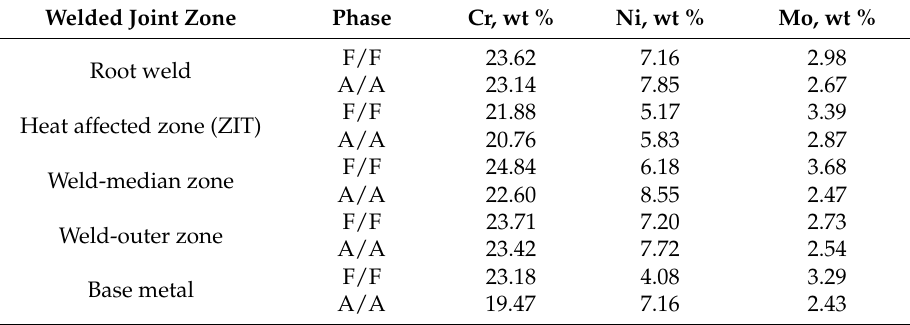
Table 3. EDX investigations on the welded joint